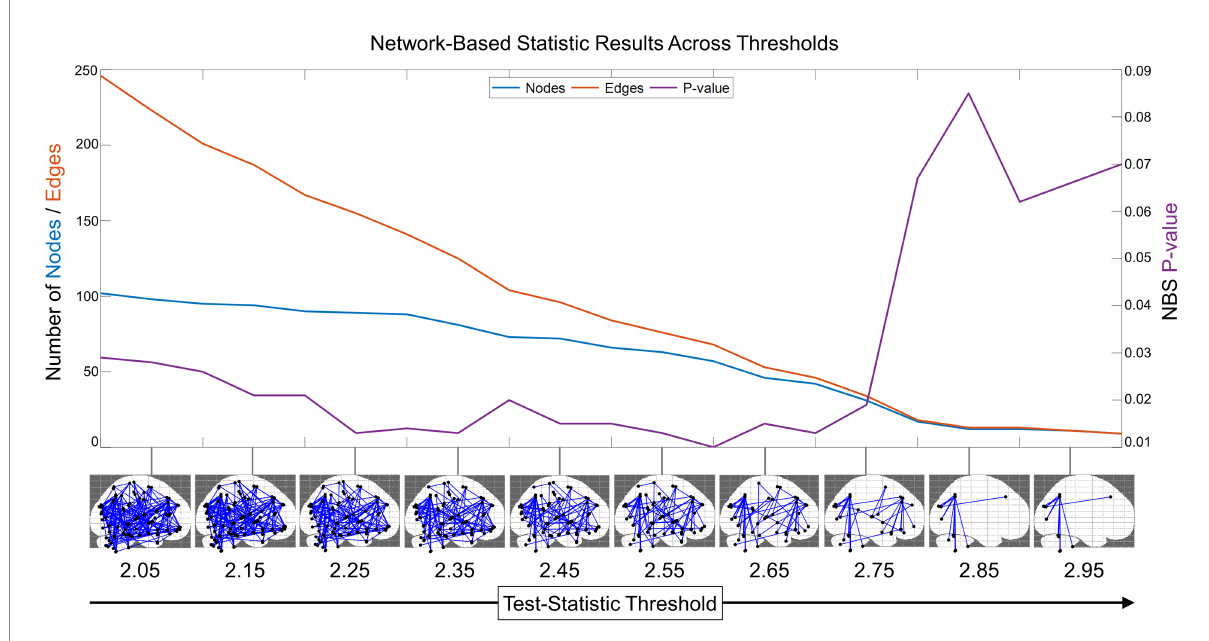
FIGURE 2 Network-based statistic (NBS) optimal threshold and sensitivity. To identify the optimal test-statistic threshold for the minimal connected subnetwork that was still significant after multiple comparisons, we computed the NBS results (with 2,000 randomized network permutations) across the interval from 2 to 3 with step size = 0.05 (for visualization purposes, NBS results in the sagittal plane are shown from 2.05 to 2.95). This revealed that the functional connectivity network has a subnetwork related to prosocial and compassionate trait-based measures that was enduring and significant across many test-statistic thresholds. The decreasing number of edges is shown in orange, the number of nodes in blue (scale on left y-axis), and the change in NBS-corrected value of p is shown in purple (scale on right y-axis). This plot reveals the optimal minimal subnetwork threshold to be test-statistic =